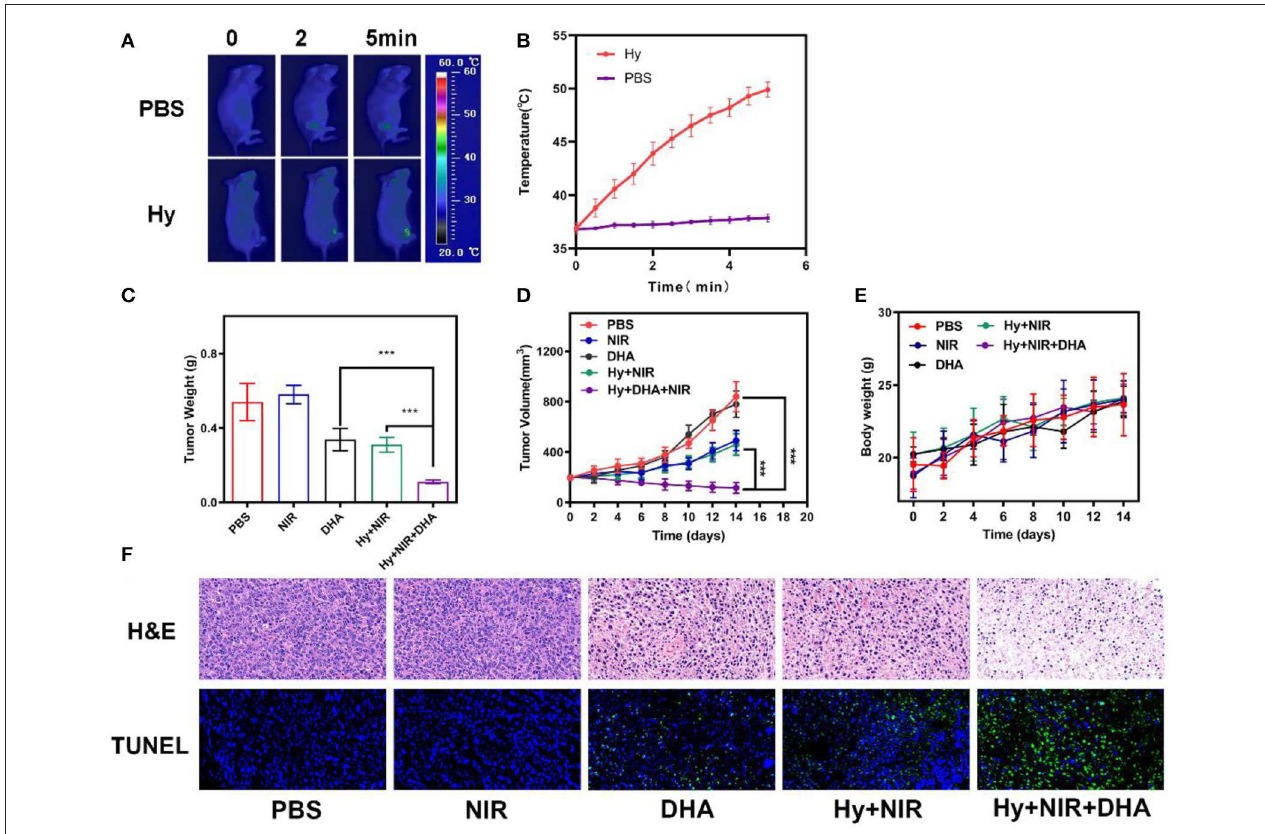
FIGURE 4 | (A) Infrared images of the mice tissue under laser irradiation after the administration of PBS and ink@hydrogel (Hy). (B) Temperature of the mice upon laser irradiation. The data represent mean ± standard deviation ( n = 3). (C) Evolution of the tumor weight during therapy. (D) Evolution of the volume of 4T1 tumors bearing female BALB/C mice after various treatments. (E) Body weight of nude mice recorded every other day for various treatments. (F) H&E and TUNEL staining of tumor sections from the 4T1 tumor-bearing mice. *** p < 0.005.